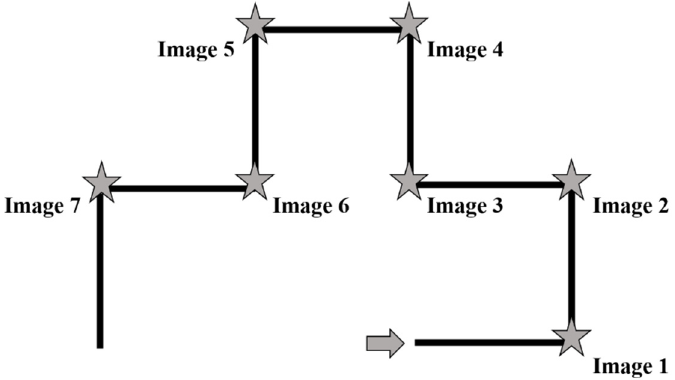
Figure 1. The figure depicts a 2D map of the route. The arrow indicates the direction and the starting point. The stars indicate the positions of the images along the route.